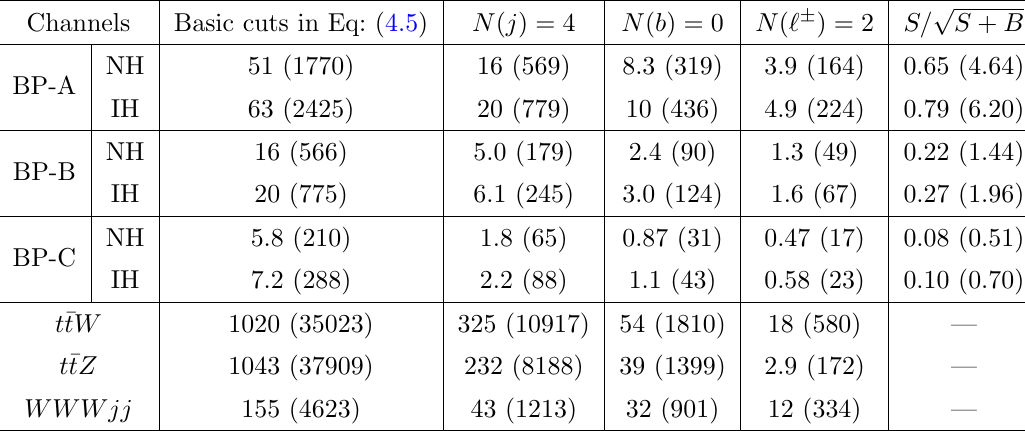
Table 4 . Cut-(cid:13)ow for the SSD signature at three benchmark points in eq. (4.2) and dominant backgrounds at LHC13@100 (LHC14@3000) for both NH and IH.